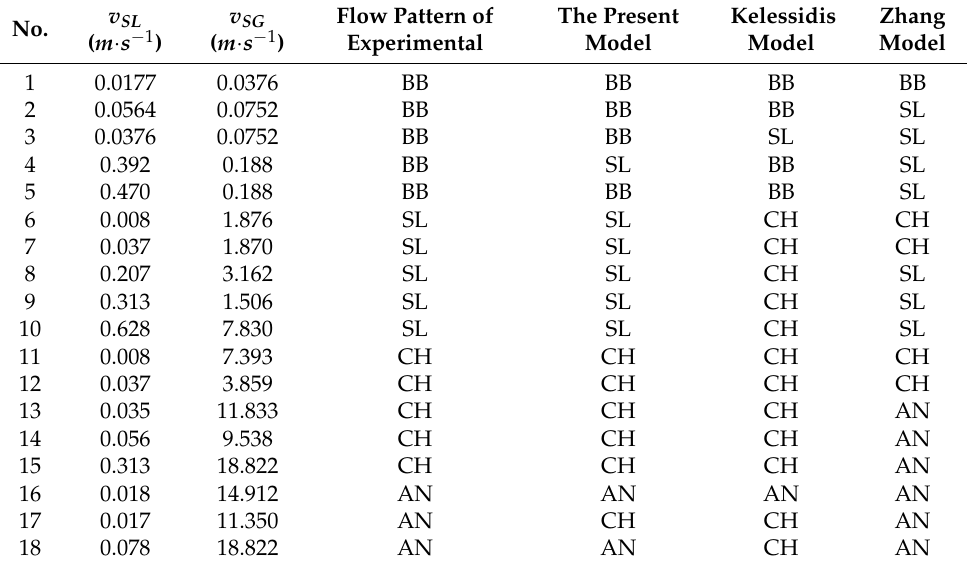
Table 2. Comparison of model predictions with experimental results at an inclination angle of 90 ◦ .